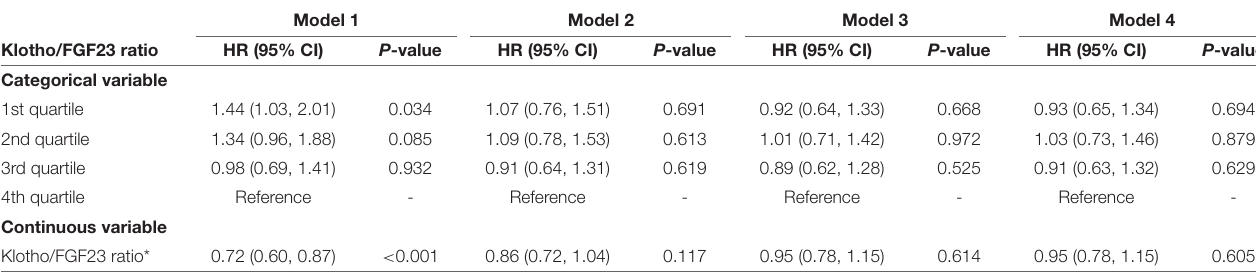
TABLE 3 | Composite of mortality and cardiovascular events according to Klotho/FGF23